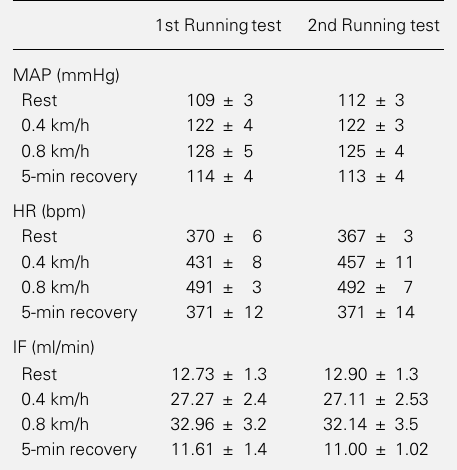
Table 2 - Comparison of mean arterial pressure (MAP), heart rate (HR) and iliac flow (IF) values in 2 running tests involving 7 normotensive rats. Resting values, maximal changes at 2 different intensi- ties and recovery values are